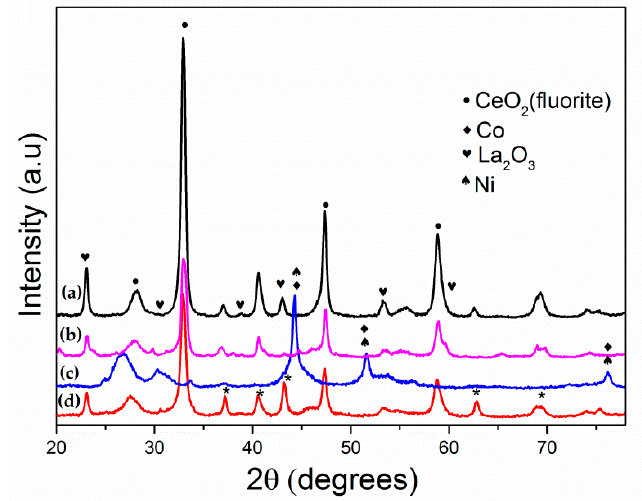
Figure 2. X-ray diffraction patterns of passivated catalysts: (a) Ni 0.7 Co 0.3 /La 0.8 Ce 0.2 , (b) Ni 0.4 Co 0.6 /La 0.8 Ce 0.2 , (c) Ni 0.1 Co 0.9 /La 0.8 Ce 0.2 , and (d) Co/La 0.8 Ce 0.2.